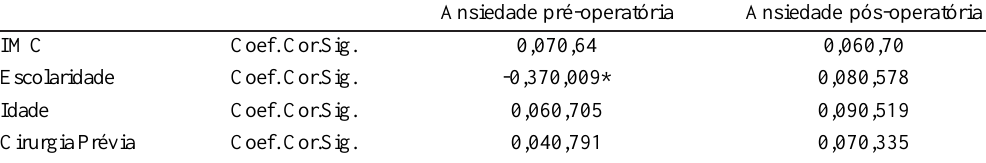
Tabela 3. Correlação entre IMC, escolaridade, idade, cirurgia prévia e ansiedade pré e pós-operatória.